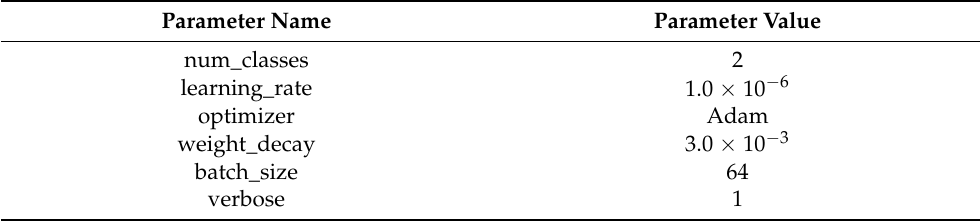
Table 5. Configuration of key parameters of the MVI prediction module in MVI-Mind